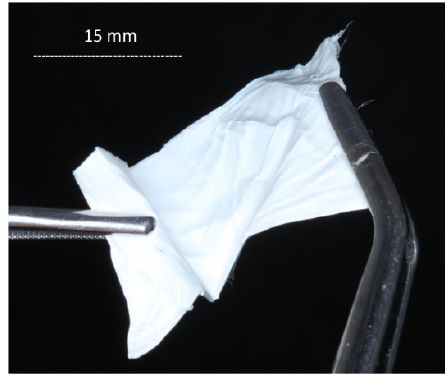
Figure 1. A fiber net prepared via the electrospinning method.